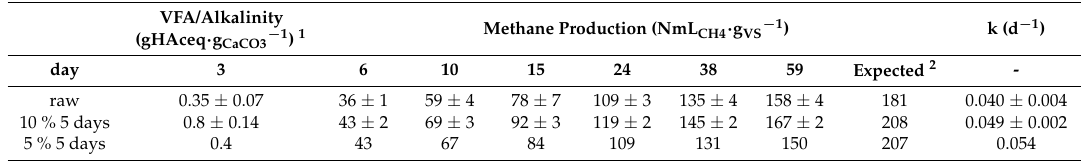
Table 3. VFA/alkalinity ratio at 3 days, methane production at 6, 10, 15, 24, 29, and 59 days, expected methane production calculated from BMP values, and first-order kinetics constants.